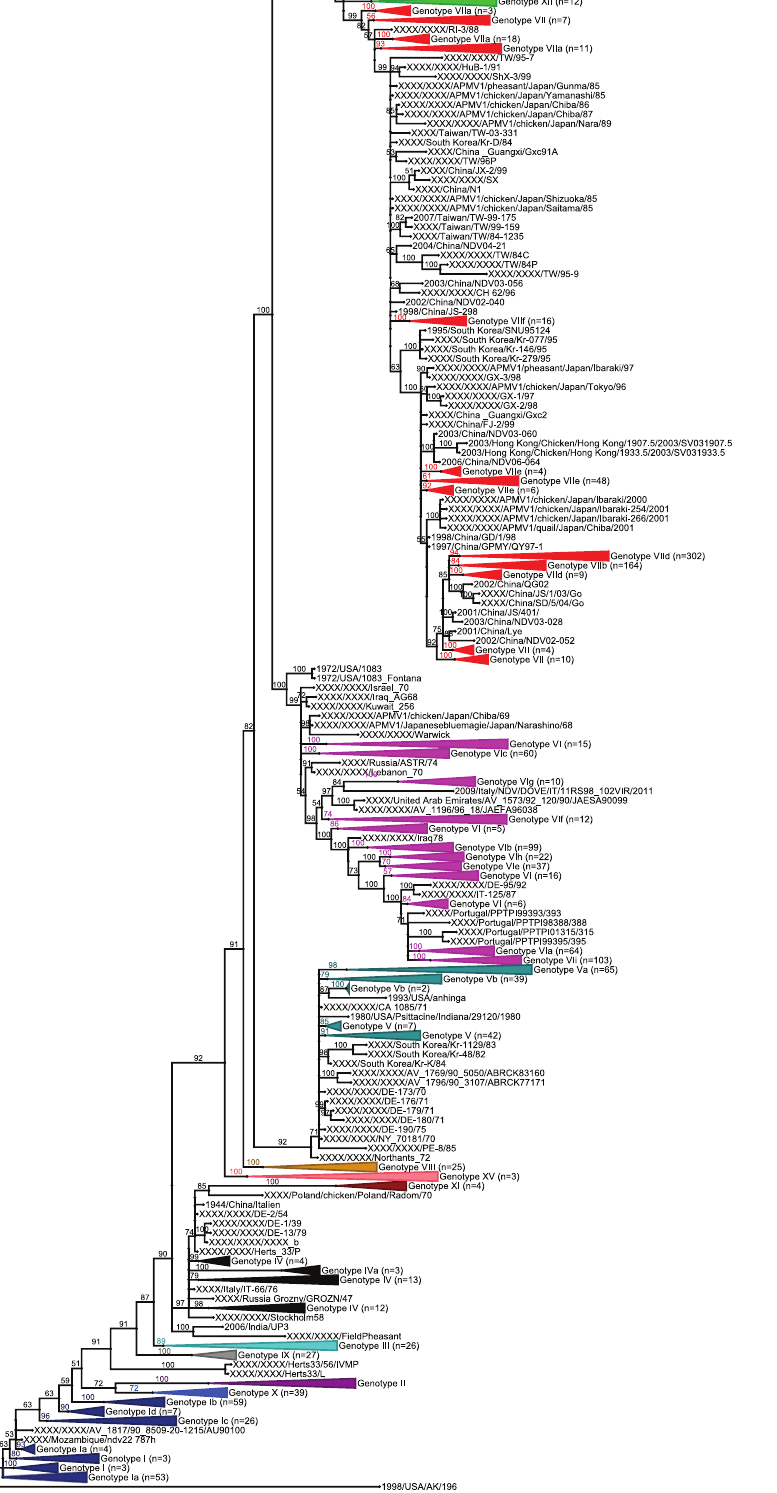
Figure 4. Phylogenetic analysis of 1921 partial F gene sequences based on nucleotides from positions 1 to 372. Trees were constructed using Bayesian inference with 47,408,000 iterations and 1/1000 tree sampled in the chain. Minimal average ESS for all parameters was 88,